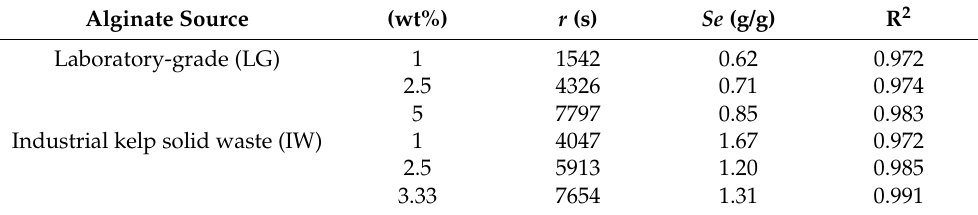
Table 2. Rate parameters ( r ) and the equilibrium swelling ratios ( S e ) determined for hydrogels in deionised water at room temperature using the Voigt model. Hydrogels tested were produced using industrial kelp solid waste extracted alginate slurries of varying solid contents (1, 2.5 and 3.33 wt%) and also hydrogels produced from laboratory-grade sodium alginate solutions of varying concentrations (1, 2.5 and 5 wt%). The coefficient of determination (R 2 ) indicates how accurately the Voigt model fits the swelling results. Alginate Source